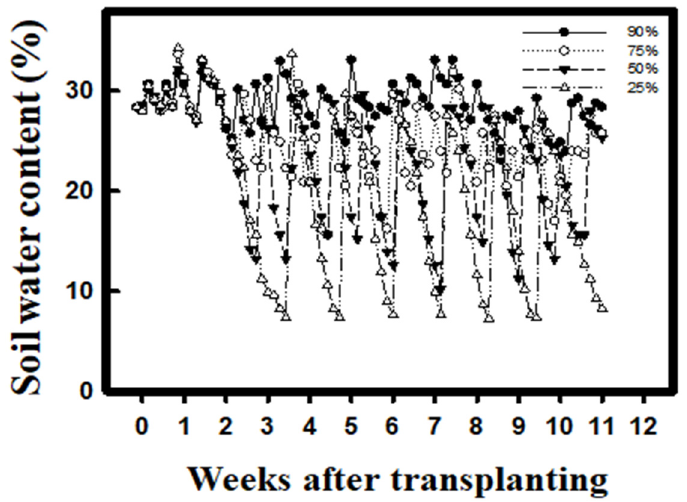
Figure 7. Soil water content change during growth